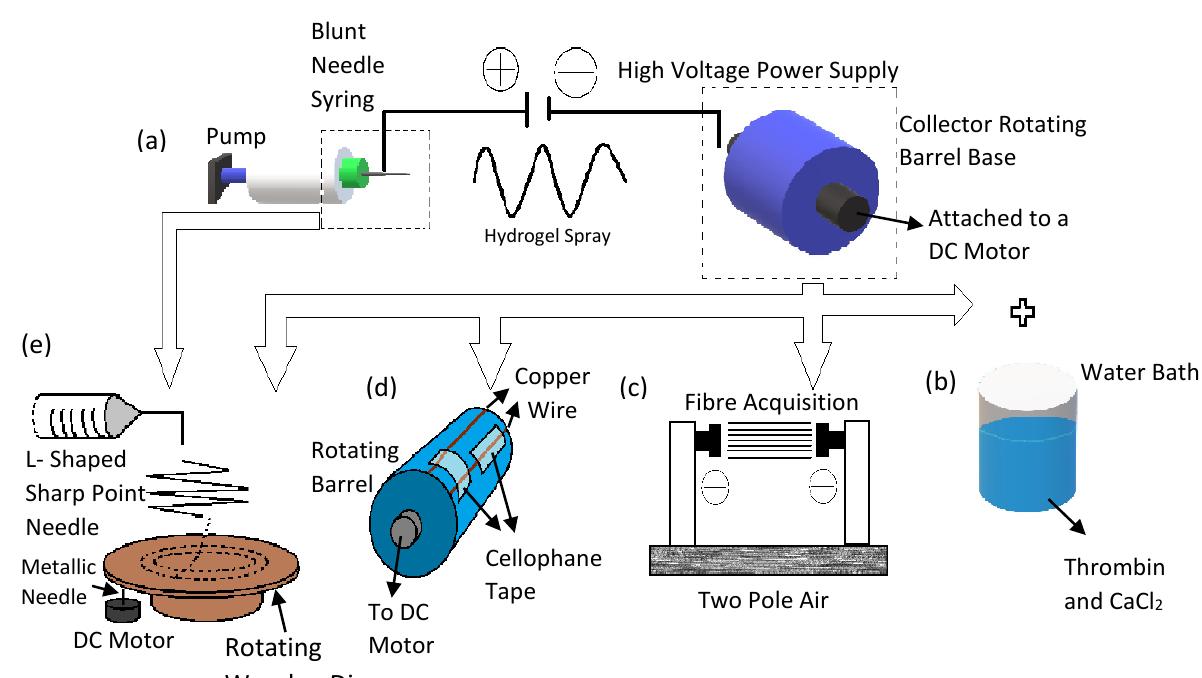
Figure 3. This diagram illustrates the electrospinning process and its numerous modifications seen in neural scaffold fabrication. ( a ) The basic electrospinning setup. ( b ) Electrospinning combined with the wet spinning setup. ( c ) Two pole air gap spinning. ( d ) Modifications made to the rotating drum to produce scaffolds of dual morphology. ( e ) New novel electrospinning design that uses a rotating wooden disc to collect fibers.